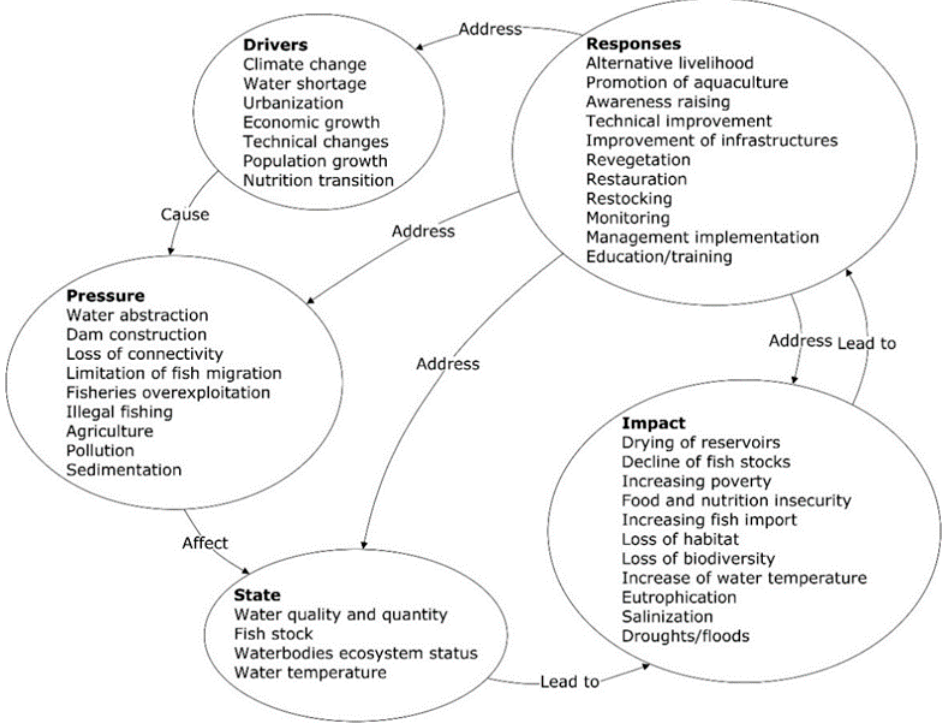
Figure 2. DPSIR relating to the BF aquatic ecosystem. The figure is a simplified representation of key factors in the interaction rather than the entire system. It is based on results from literature reviews and interviews. Source: Modified after Hundscheid [62].